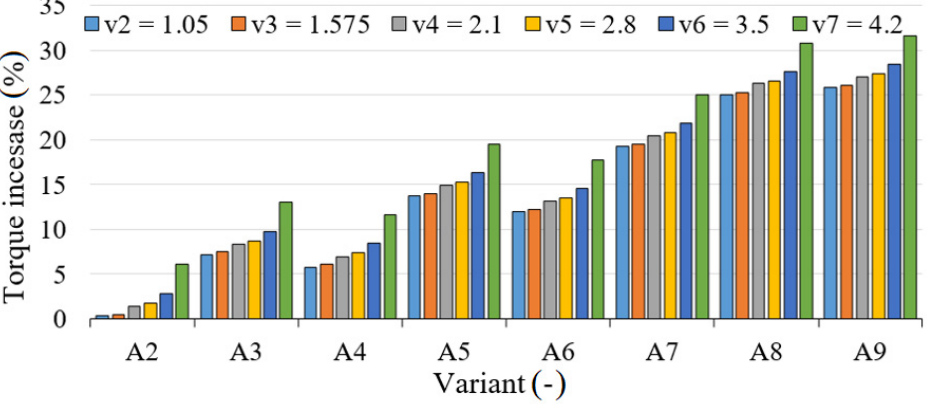
Figure 13. Change in torque demand in relation to the experiment variant and the simulated wheelchairs velocities.